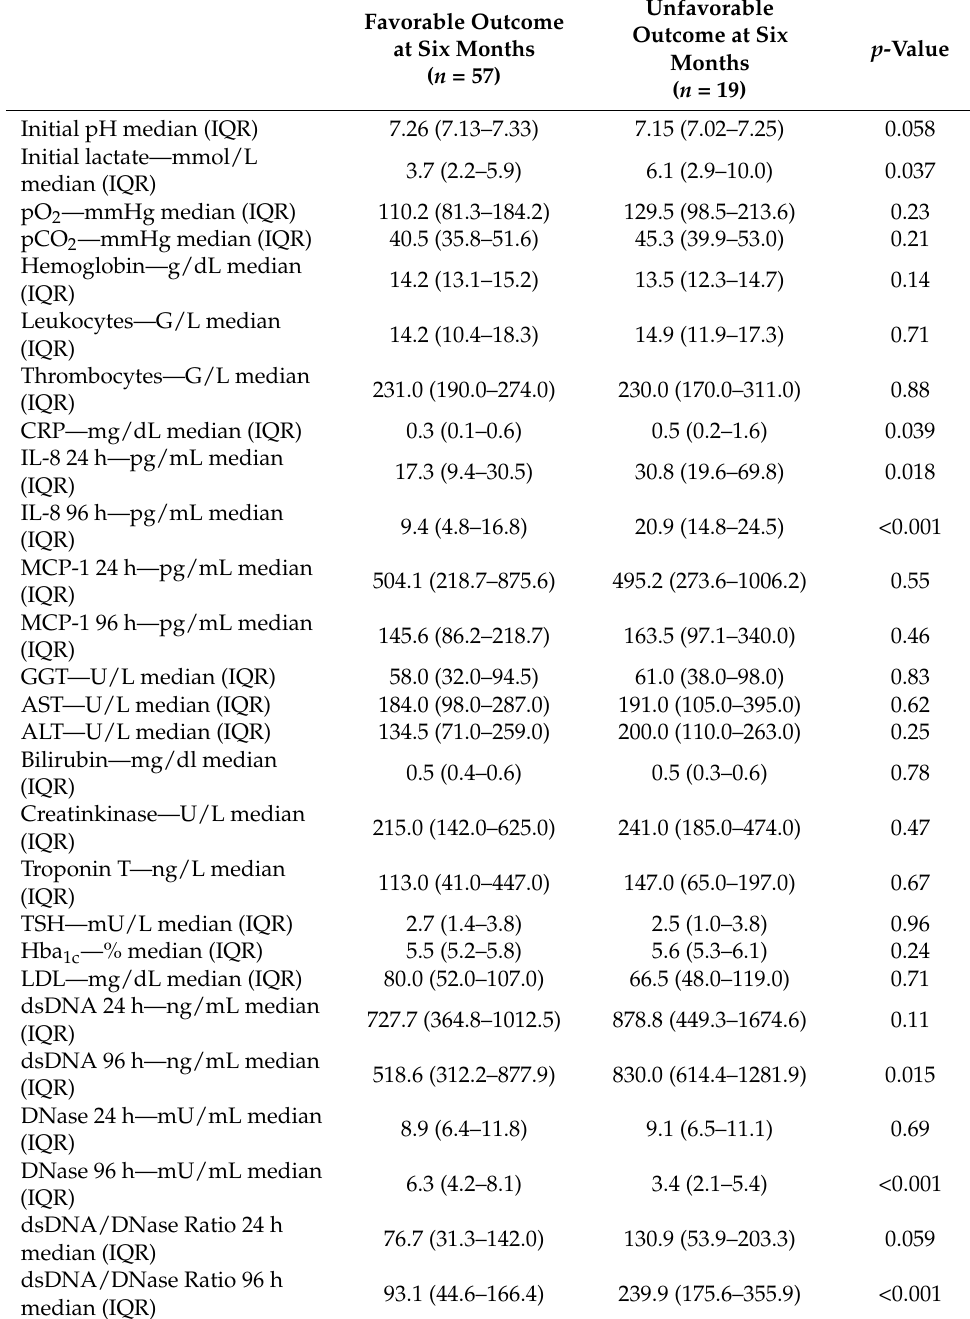
Table 2. Laboratory data in patients with favorable vs. unfavorable outcome (death or CPC ≥ 3 after six